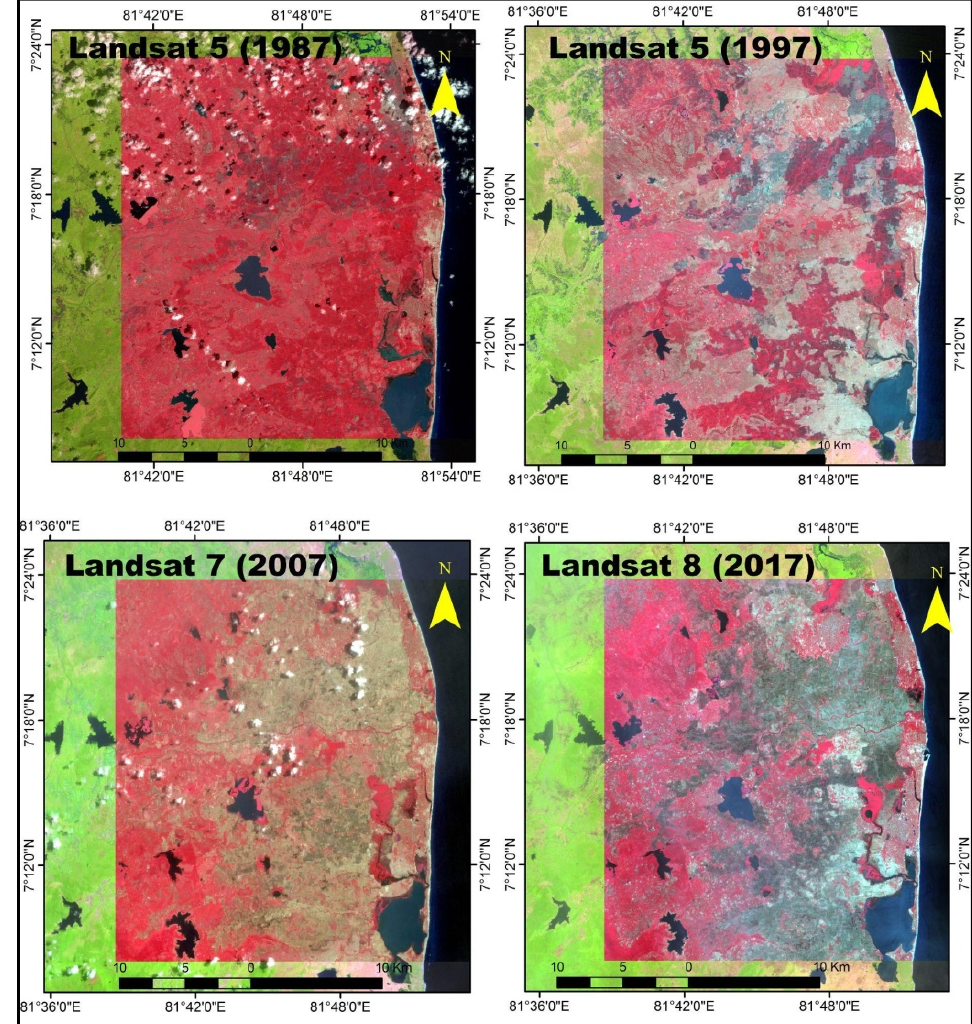
Figure 2. Landsat images of false-color combination for 1987 and 2017 period at the east coast of the Ampara District in Sri Lanka. The coordinate system of the study area is WGS 84 UTM Zone 44 N.